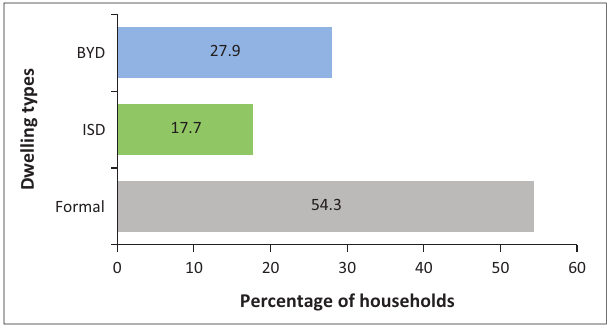
FIGURE 3: Percentages of households surveyed by dwelling type ( n =